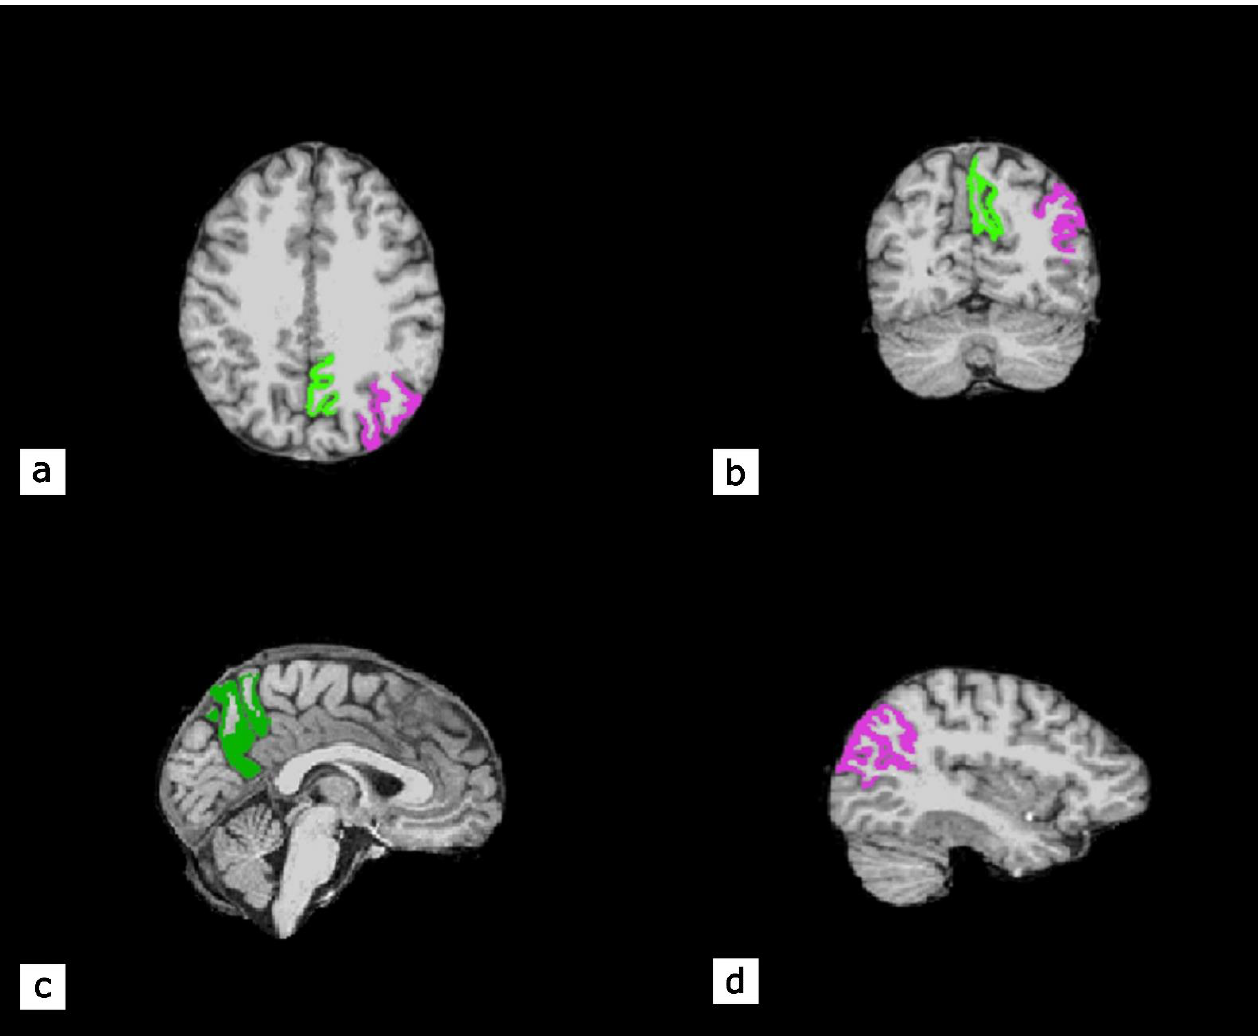
Figure 5. An illustrative example of magnetic resonance imaging-based brain volumetry analyses of functional neuroimaging data in a patient with OA confirms the alteration of the structures in the left parietal lobule. Surface-based volumetry demonstrates precuneus (colored in green) and inferior parietal gyrus (colored in purple). ( a ) Axial plane; ( b ) Coronary plane; ( c ) Medial sagittal plane; ( d ) Lateral sagittal plane.